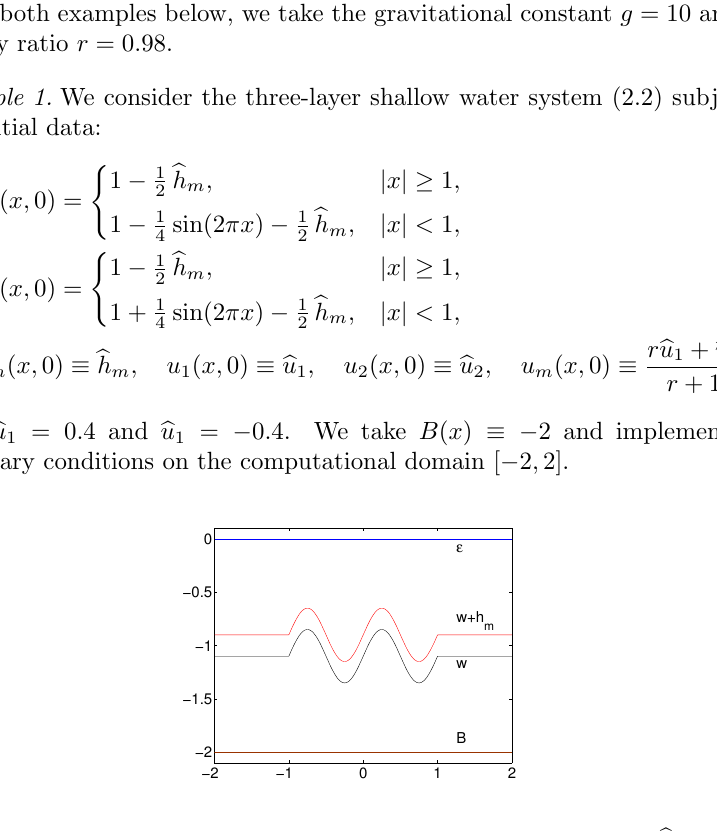
Figure 2. Example 1: The initial setting for the three-layer system with (cid:98) h m = 0 . 2. The initial setting for h m = 0 . 2 is shown in Fig. 2. The simulations are run on the uniform grid with ∆x = 1 / 200 until time t = 0 .